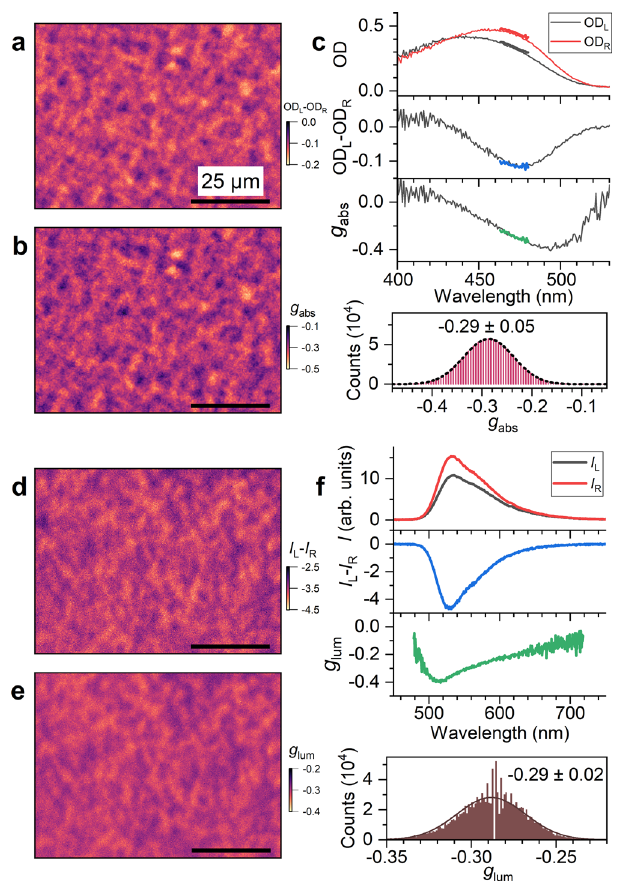
Fig. 2 CD and CPL imaging with diffraction-limited resolution of about 500 nm. a Microscope image (80 × 60 μ m 2 ) for the circular dichroism of a c-PFBT thin fi lm. b Corresponding image for the dissymmetry factor g abs . c Wavelength-dependent optical density for LCP (black) and RCP detection (red), the resulting CD signal and the g abs spectrum (thin lines: full spectra, thick coloured lines: spectral region selected by the bandpass fi lter at 470 nm used for CD imaging) as well as the g abs histogram with a Gaussian fi t (dashed black line), all determined over the entire fi eld of view (210 × 160 μ m 2 ). d Microscope image for the circularly polarised luminescence at another position on the same c-PFBT thin fi lm. Excitation at 365 nm. e Corresponding image for the dissymmetry factor g lum . f Wavelength-dependent photoluminescence spectrum for LCP (black) and RCP detection (red), the resulting CPL signal and the g lum values for the c-PFBT emission band, as well as the g lum histogram with a Gaussian fi t (solid black line), all determined over the entire fi eld of view. The length of the black scale bar in each image corresponds to 25 μ